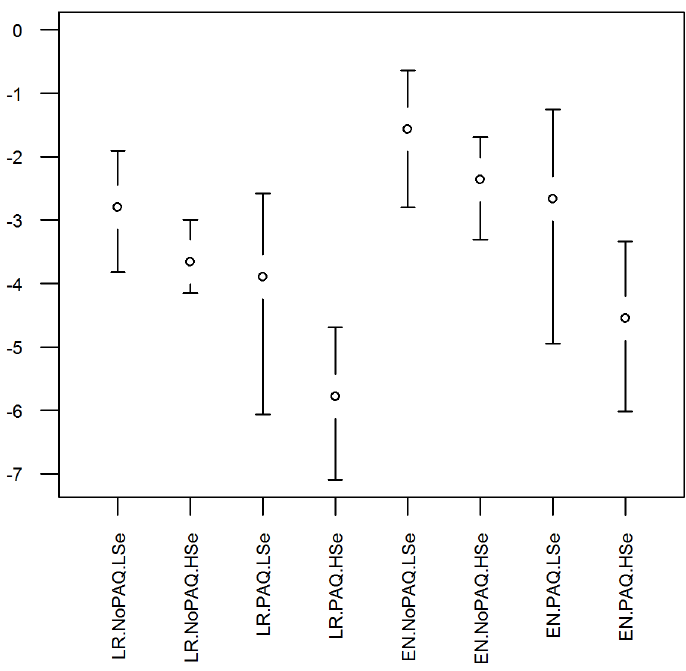
Fig 4. Median and 95% predictive intervals for the log (base 10) of annual probability of exporting one or more undetected AHS-infected horses. Assumes 300 horses exported per year. LR, Low-risk area; EN, Endemic area; NoPAQ, No post-arrival quarantine or PCR; PAQ, Post arrival quarantine and PCR at destination; PCR, real-time reverse transcription polymerase chain reaction assay; LSe, lower PCR sensitivity estimate used; HSe, higher PCR sensitivity estimate used.